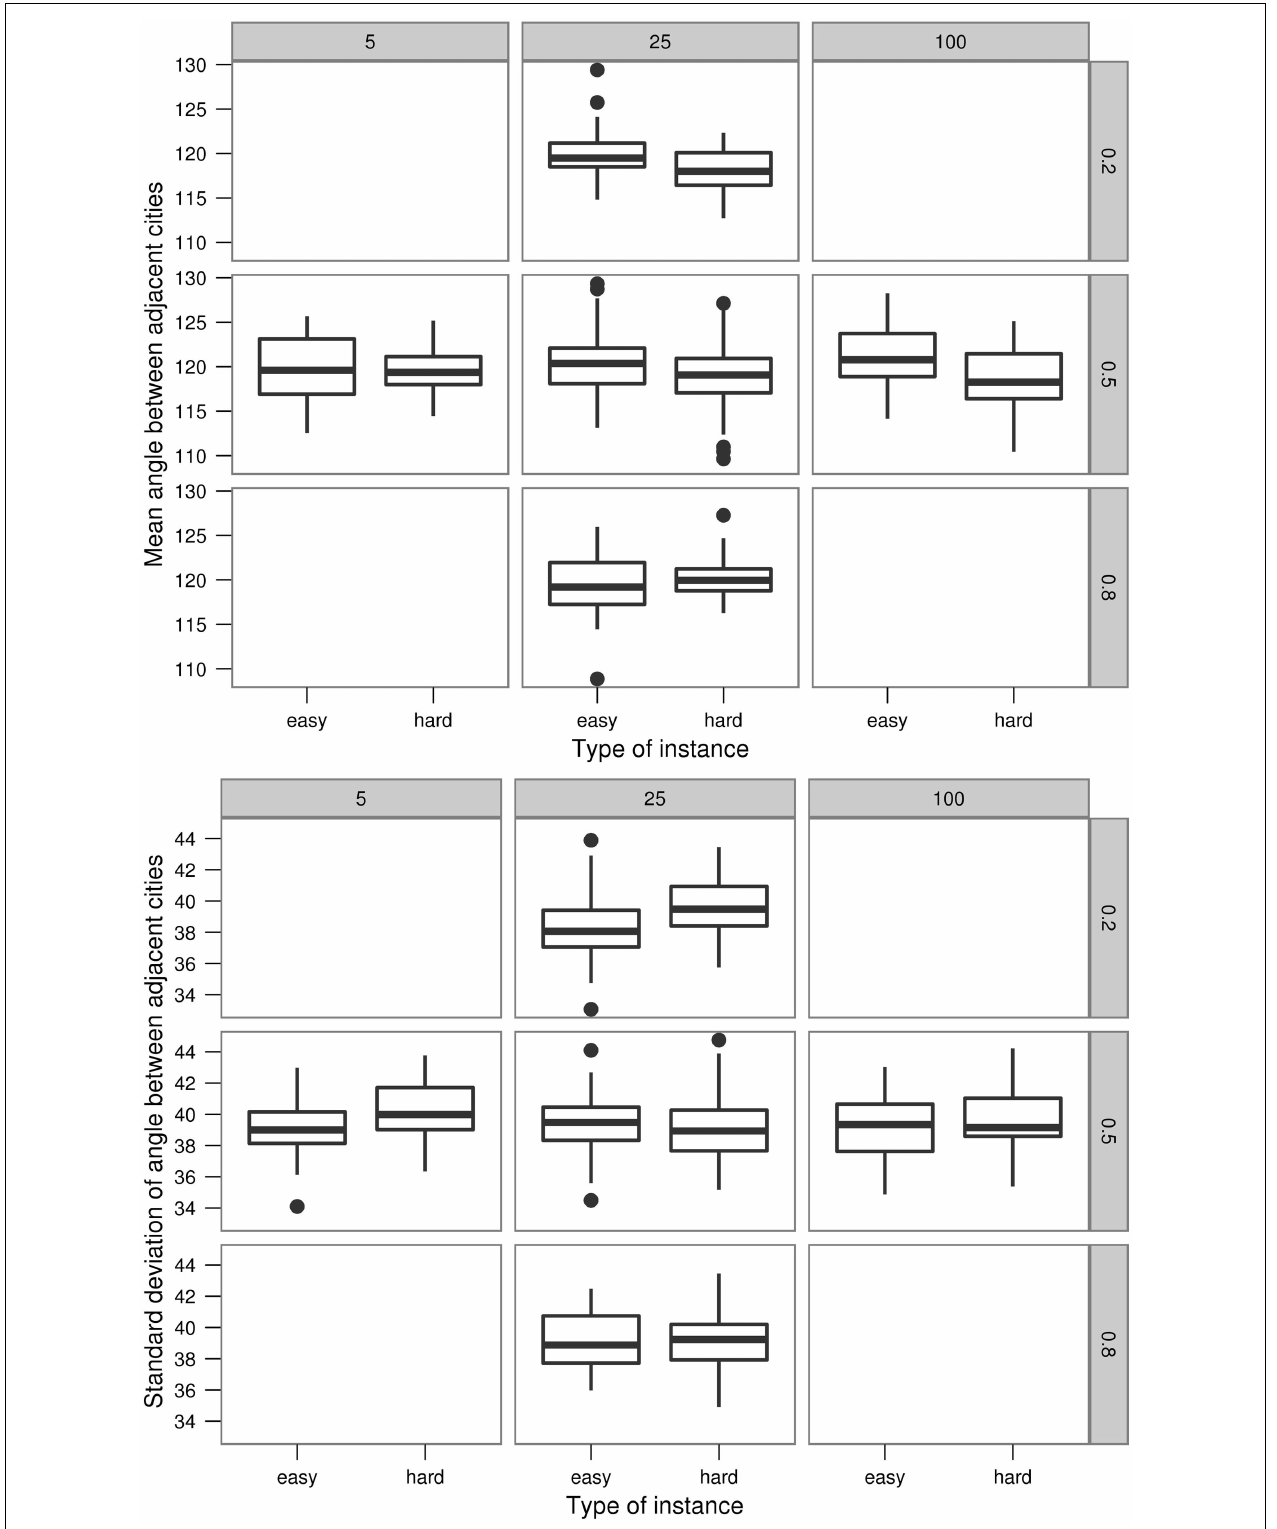
FIGURE 8 | Boxplots of the means and the SDs of the angles between neighbor cities .